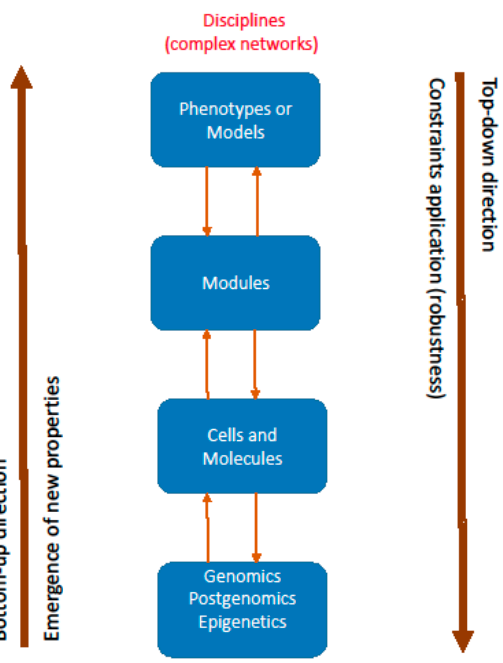
Figure 1. Concepts of systems biology: bottom-up and top-down directions; disciplines (complex networks); emergence of new properties; constraints application (robustness).